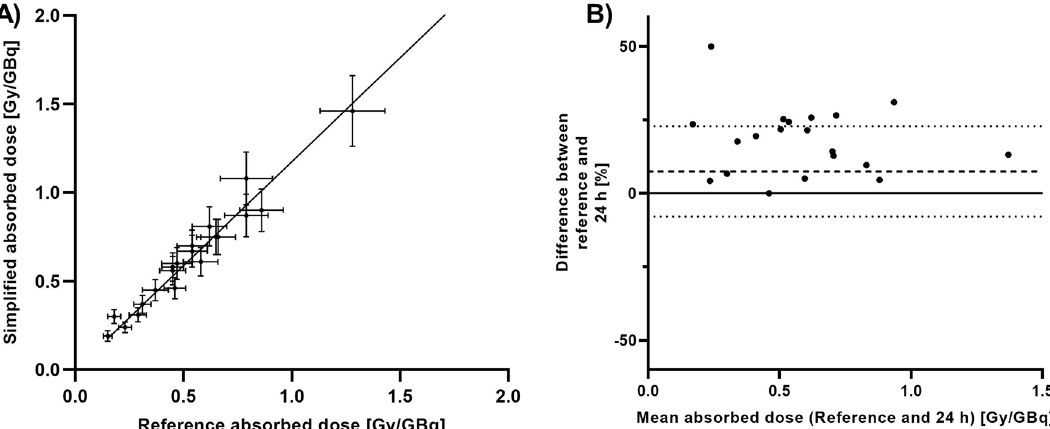
Fig. 4 Results of organ dosimetry based on a single SPECT at 24 h compared to the reference standard for salivary glands. A concordance between the absorbed dose according to the new method ( y -axis) and the reference standard ( x -axis). The diagonal line is the line of perfect concordance. B Bland–Altman plot showing the mean difference between both methods as a function of the mean absorbed dose of both methods. The upper and lower dashed lines indicates the limits of agreement